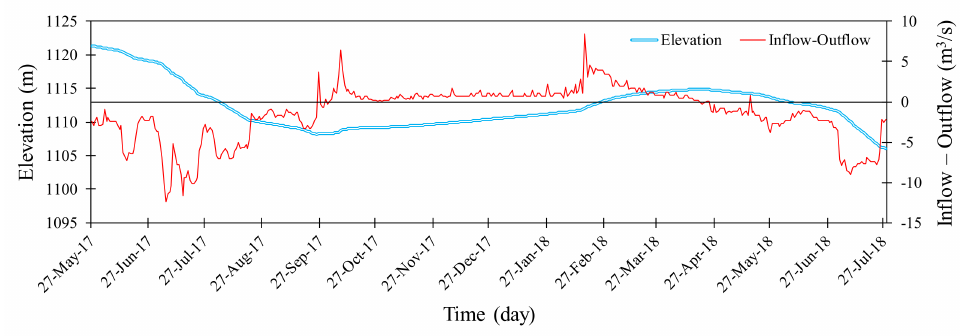
Figure 6. Inflow to the reservoir and the elevation of water throughout the study